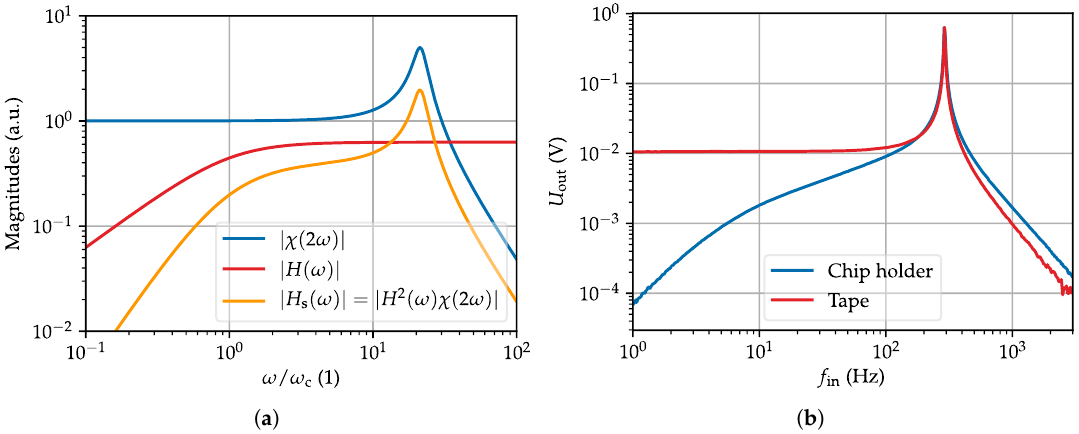
Figure 3. ( a ) Frequency dependent magnitudes of the functions χ ( 2 ω ) (blue), H ( ω ) (red) and H 2 ( ω ) χ ( 2 ω ) ∝ A ( ω ) (orange). It can be seen that the parasitic resistance significantly